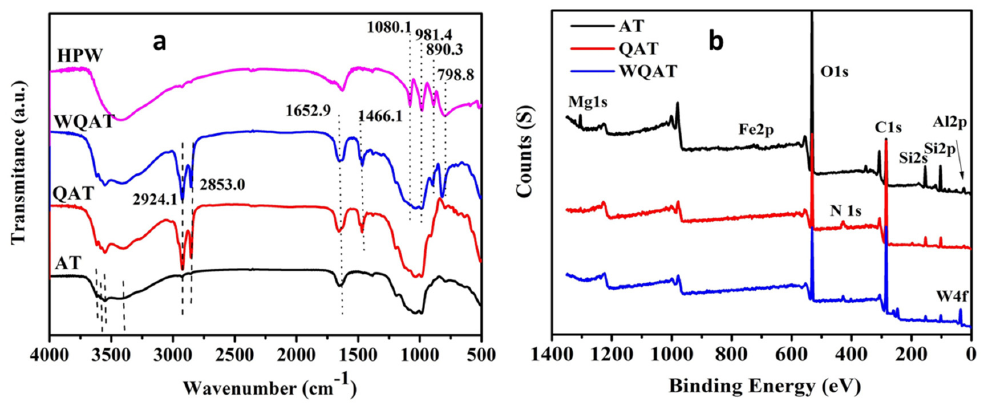
Figure 1. ( a ) FTIR and ( b ) XPS full-scan spectra of AT and functionalized AT.